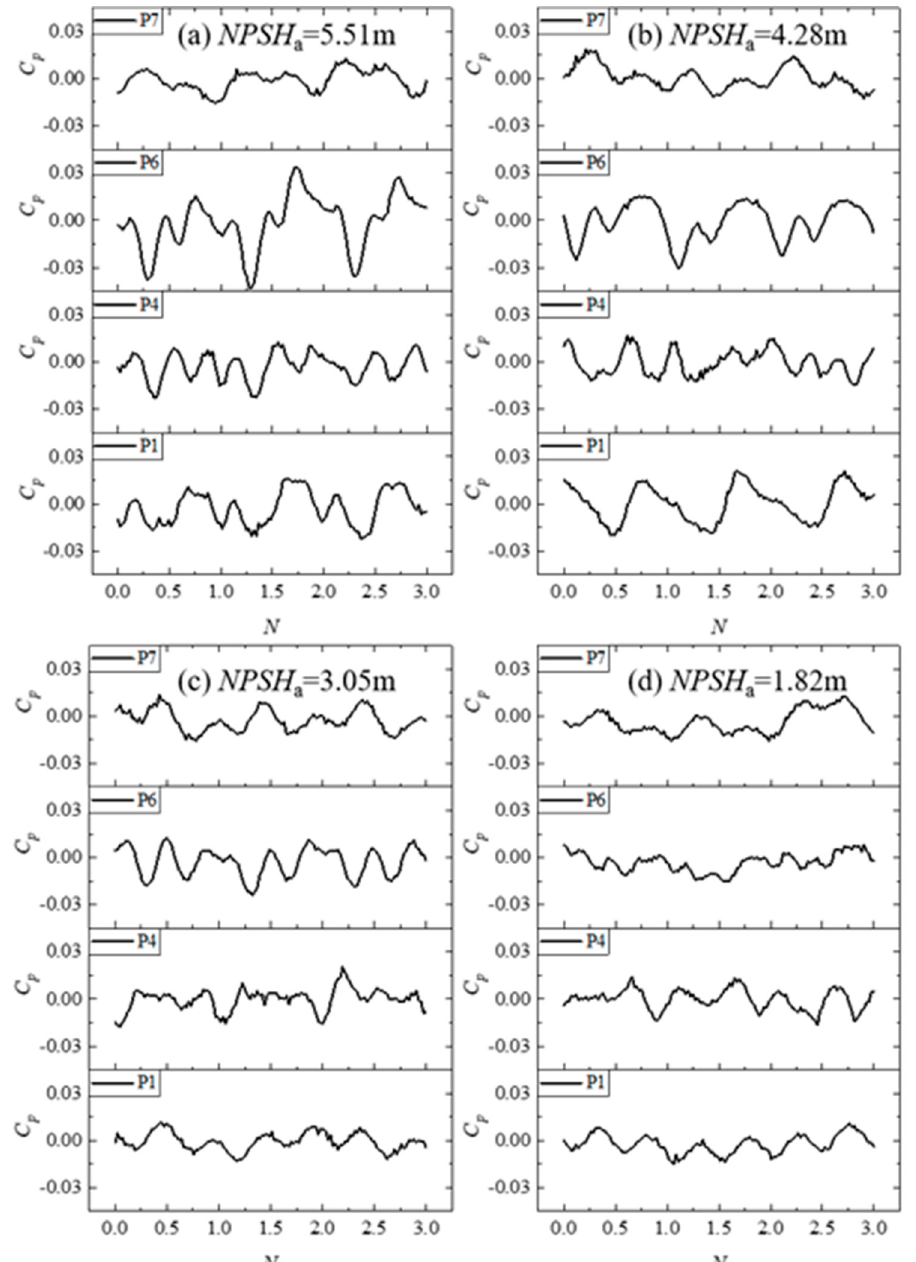
Figure 10. Time domains of pressure fluctuations under different